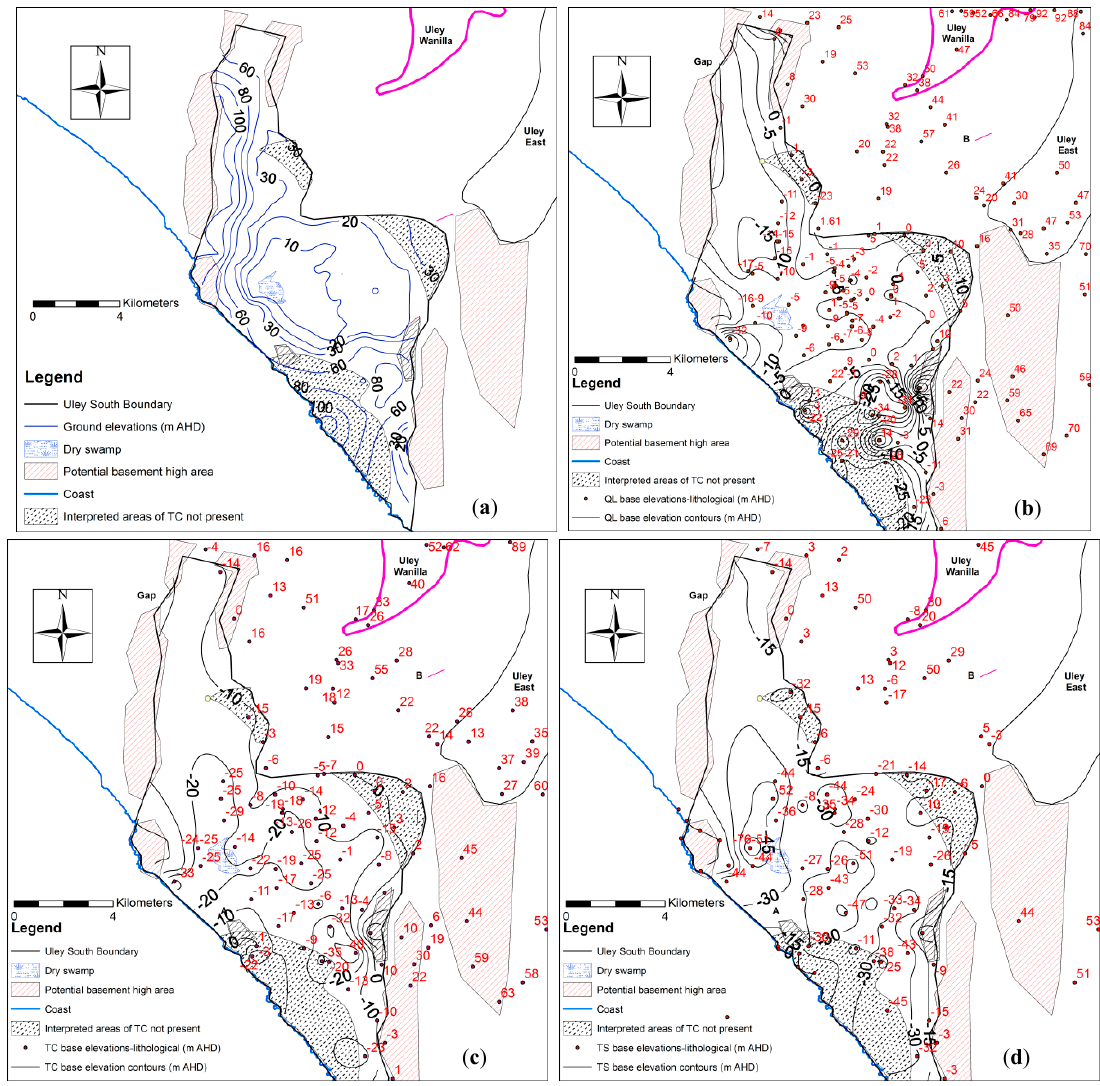
Figure 3. ( a ) Ground elevation contours; ( b ) QL base elevations; ( c ) TC base elevations; ( d ) TS base elevations.